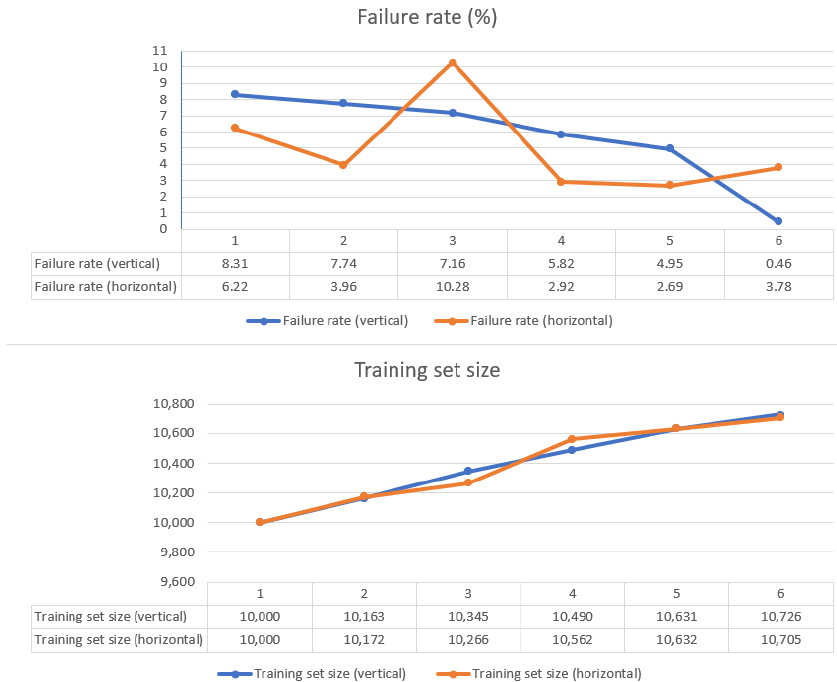
Figure 14. Top: The failure rates of the 6 different models used during the evaluation in the vertical and horizontal test configurations. Bottom: The size of the training sets used to train the 6 models.